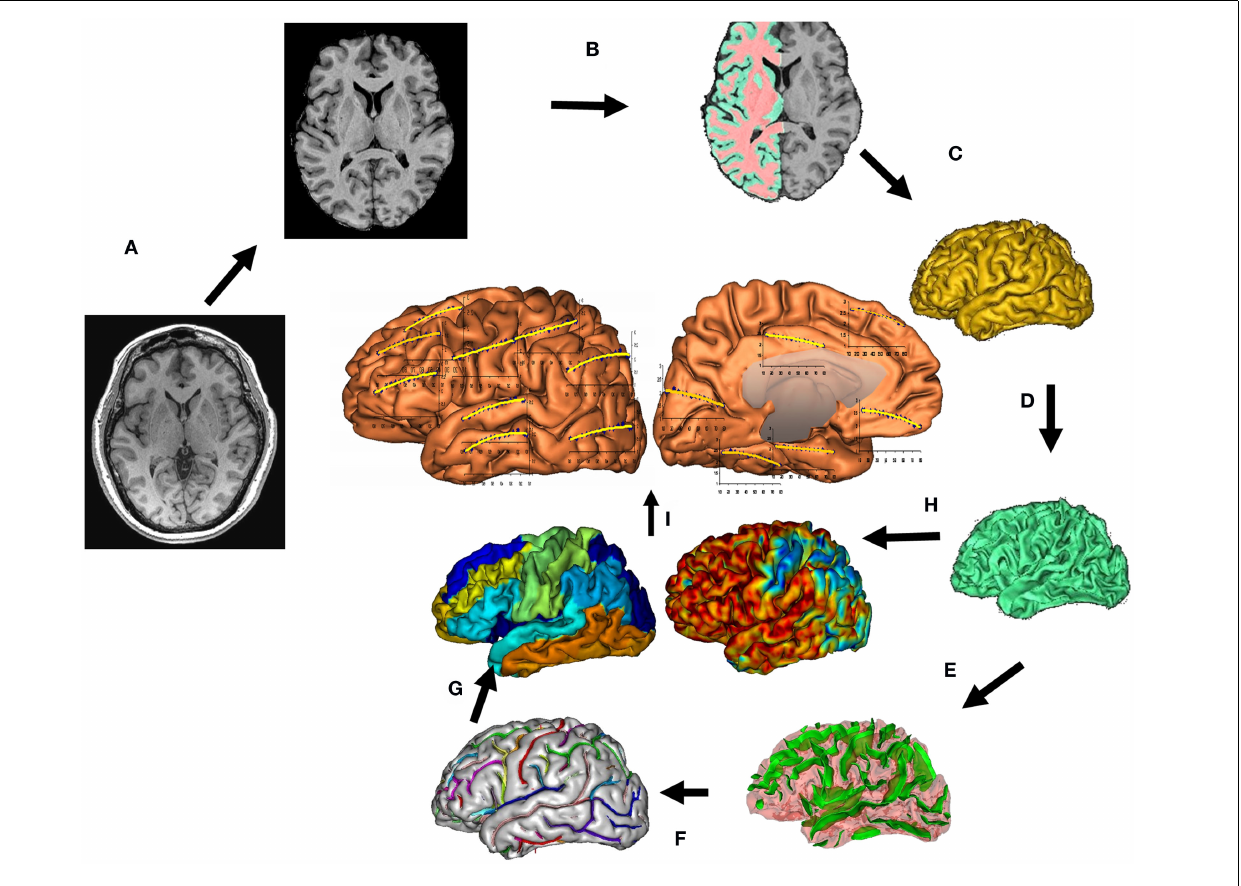
banks (E) . Sulcal identification pipeline uses a congregation of 500 artificial neural network-based pattern classifiers to identify (F) sulcal landmarks and to perform gyral segmentation of the cortex (G) . GM thickness was calculate as the distance between the pial (C) and GM/WM interface surfaces (H) . (I) Average GM thickness was calculated 14 primary cortical